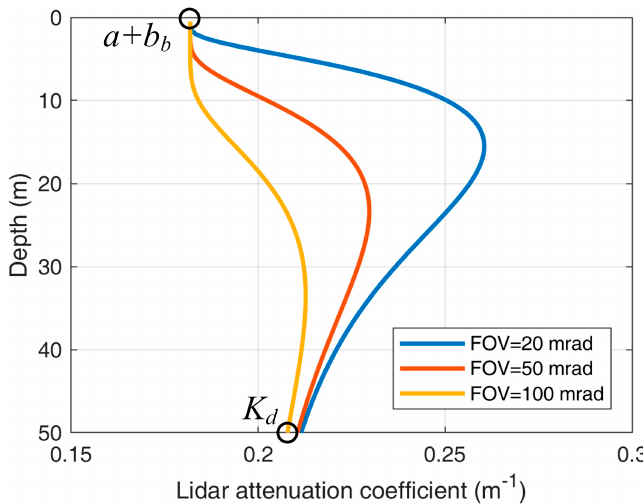
Figure 8. The lidar attenuation coefficient is calculated from lidar signals of the analytical model in Figure 2b. K d is 0.207 m − 1 according to [10] .